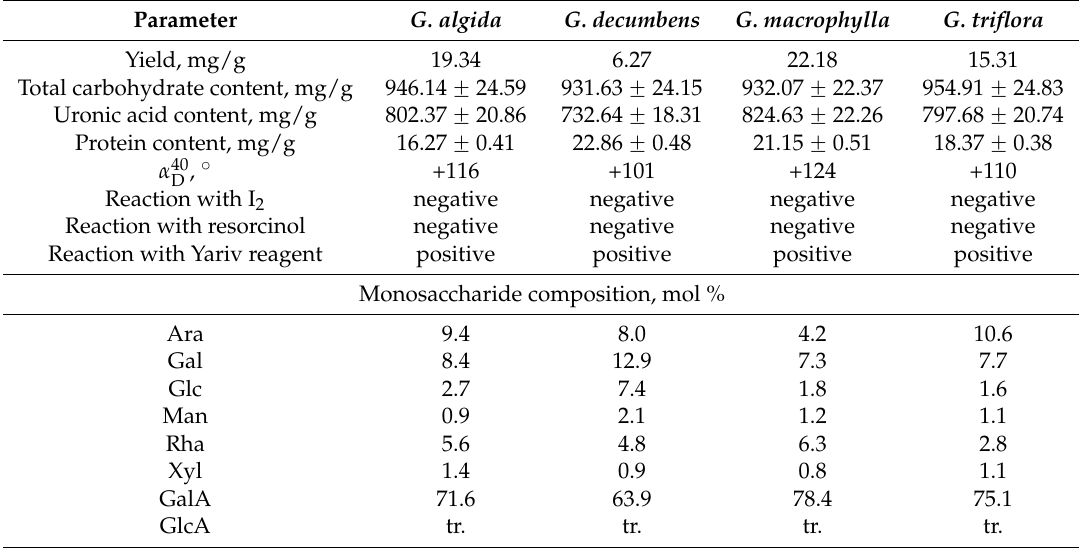
Table 3. General parameters and monosaccharide compositions of water soluble polysaccharide fractions of bitter gentian